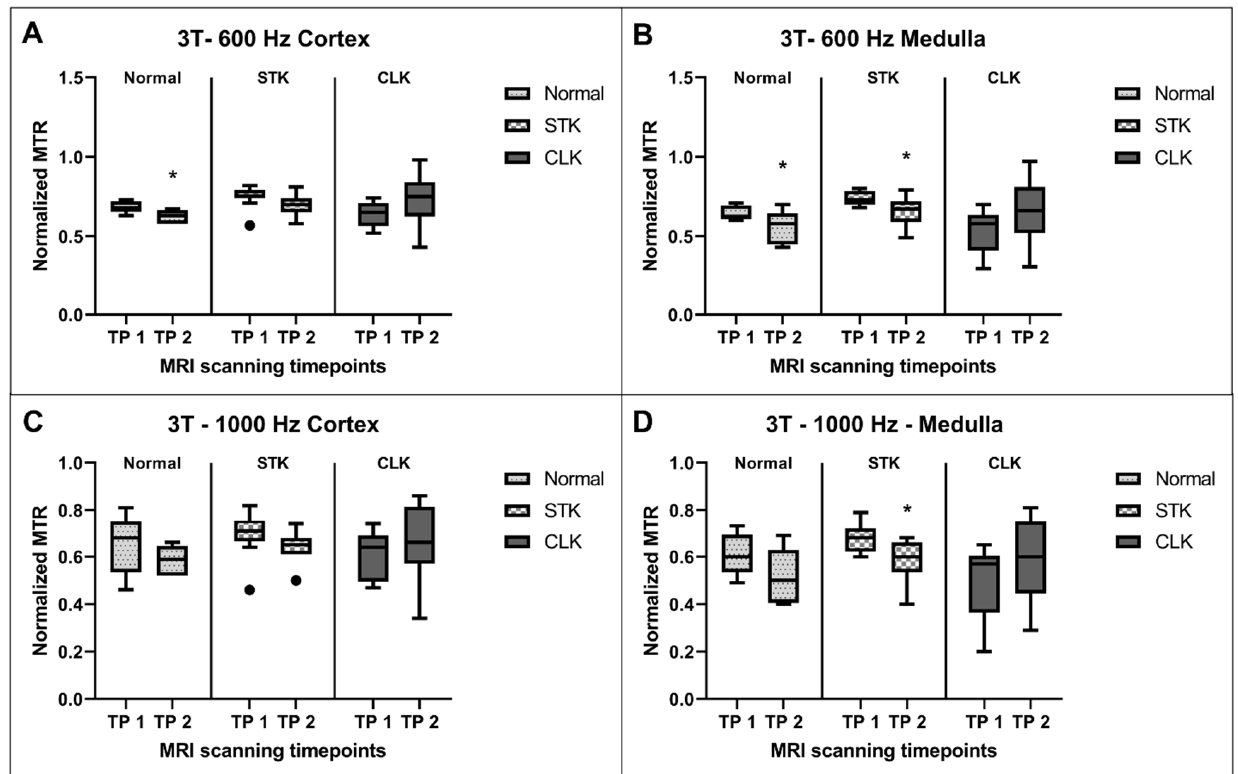
Figure 4. Normalized MTR values compared between the two timepoints (TP) for the normal, stenotic, and contralateral kidneys at 3T at 600 Hz offset frequency in the cortex ( A ) and medulla ( B ) and at 1000 Hz offset frequency in the cortex ( C ) and medulla ( D ). * p ≤ 0.05 vs. first TP for the same kidney region.